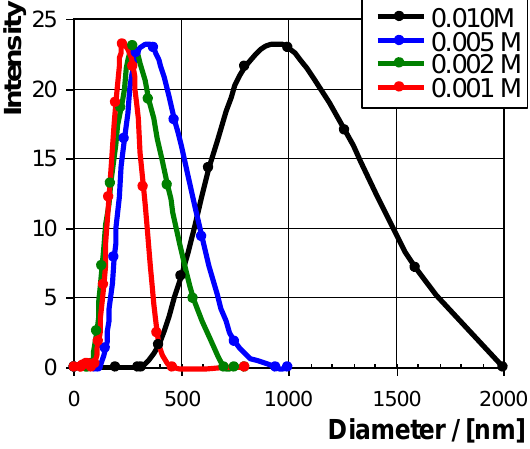
Figure 7. Intensity distributions from DLS data on PEC-0.6 dispersions of PEI/PAC in dependence of PEL concentration (c PEL